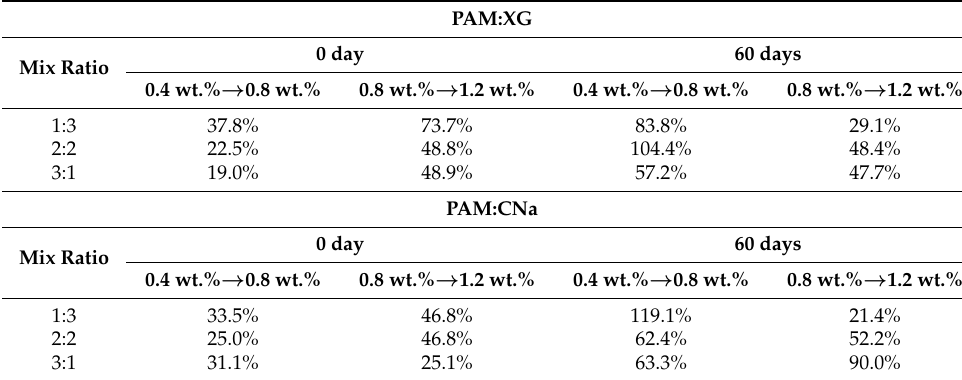
Table 2. Improve rate of dynamic viscosity at different aging times.